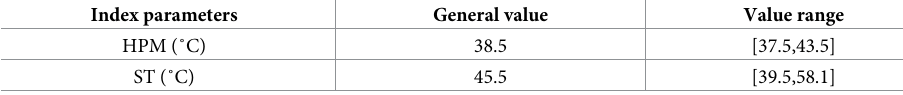
Table 6. The objective function value interval of the mild moxibustion.